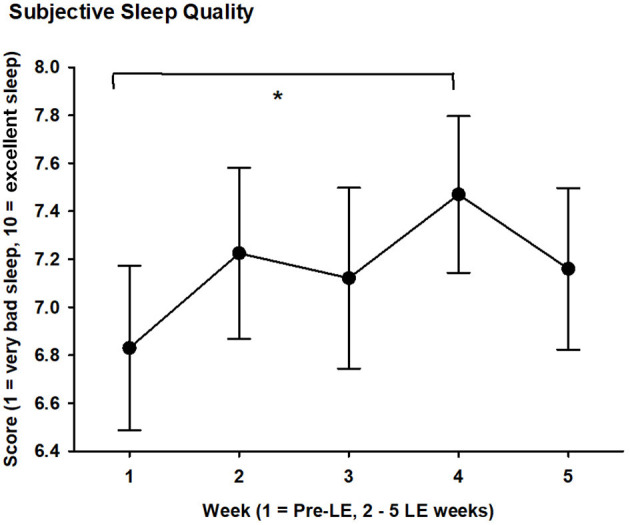
Subjective sleep quality score (1 = very bad sleep, 10 = excellent sleep) averaged per week during 5 weeks for 20 subjects with glaucoma. Mean values (black filled circles) and SEM are shown; LE = light exposure; week 1 = pre-LE week; weeks 2–5 = LE weeks. * = significant differences between weeks 1 and 4 (see text for mean value during week 4; p < 0.05).